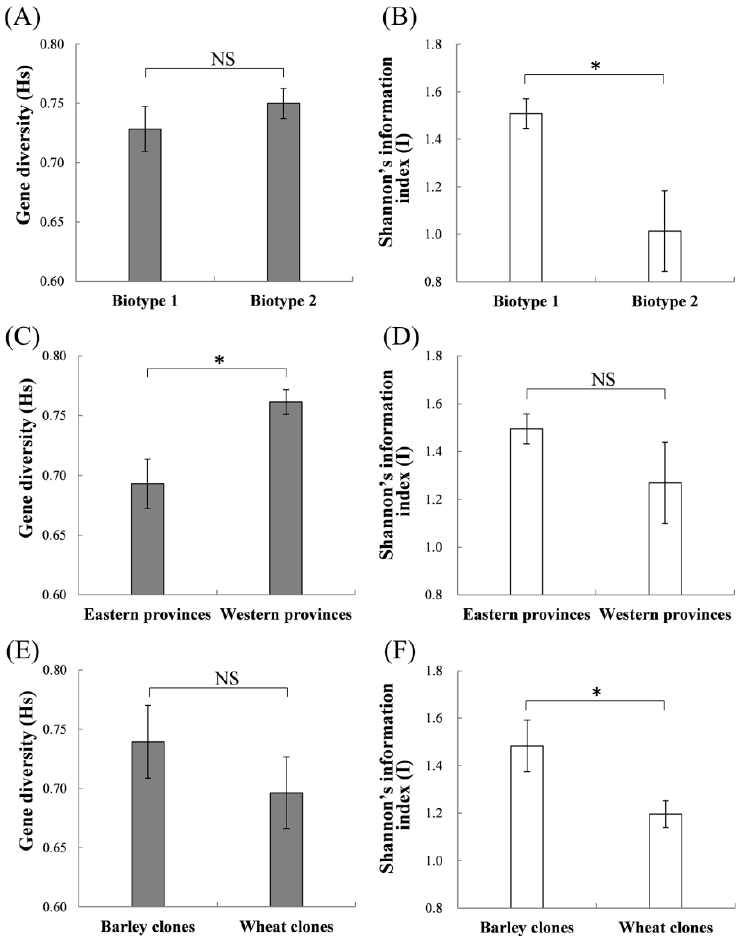
Figure 2. Comparisons of estimates for gene diversity (Hs) and Shannon’s information index (I). ( A , B ): between biotypes 1 and 2; ( C , D ): between eastern and western provinces; ( E , F ): between wheat and barley clones; eastern provinces include Anhui, Hubei, Henan, Jiangsu, and Zhejiang; western provinces include Gansu, Qinghai, Shaanxi, and Xinjiang; (*, significant differences at the p < 0.05 level; NS, non-significant).